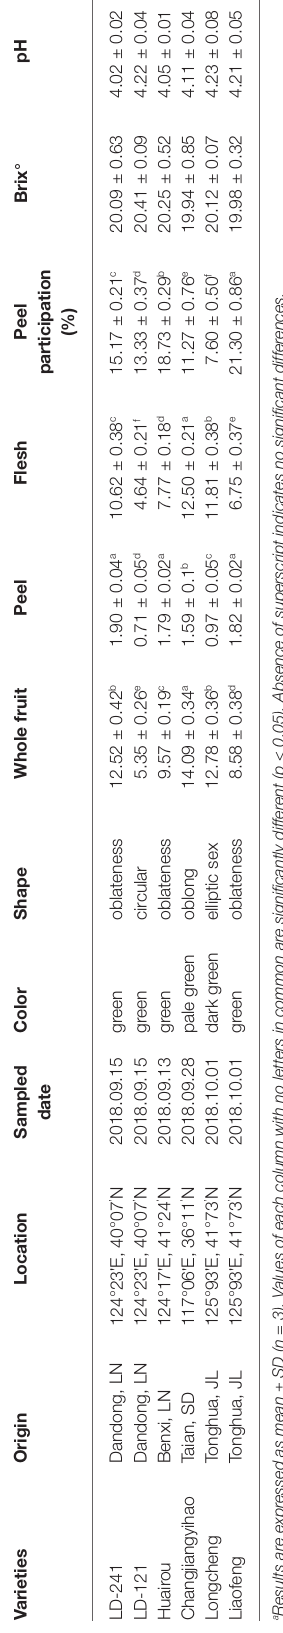
TABLE 2 | Vitamin C content of different parts of six kiwi berry varieties. a